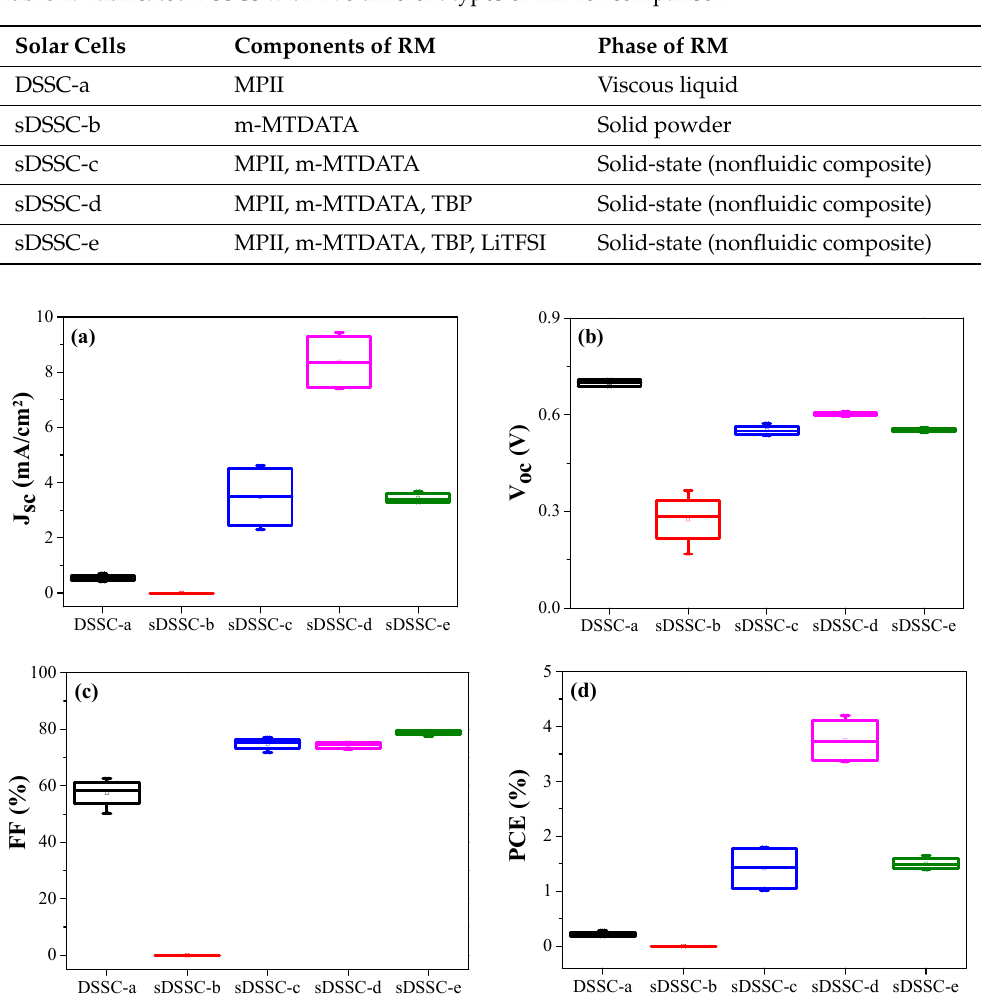
Figure 2. Box plots for photovoltaic performance of the DSSCs with five different types of RM; ( a ) J sc , ( b ) V oc , ( c ) FF , and ( d ) PCE measured under the AM 1.5 Table 2. Fabricated DSSCs with five different types of RM for comparison.